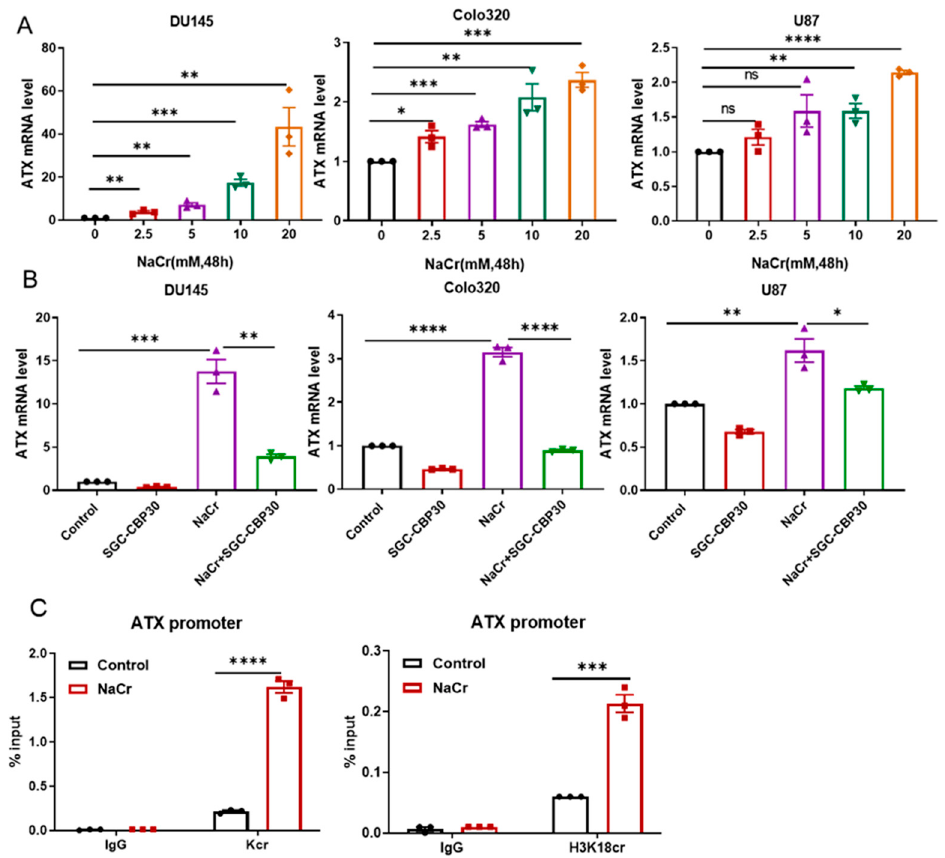
Figure 7. Histone crotonylation promotes ATX expression under normoxic conditions. ( A ) DU145, Colo320, and U87 cells were cultured under normoxic (N) conditions in the absence or presence of NaCr (0, 2.5, 5, 10, or 20 mM) for 48 h. ( B ) DU145, Colo320, and U87 cells were cultured under normoxic (N) conditions in the absence or presence of NaCr (10 mM) and/or the p300/CBP inhibitor SGC-CBP30 (25 µM) as indicated for 48 h. ATX mRNA levels were measured using RT ‒ qPCR ( A , B ). ( C ) DU145 cells were cultured under normoxic conditions in the absence or presence of NaCr (10 mM) for 48 h and then subjected to ChIP assays with anti-Kcr and anti-H3K18cr antibodies. The PCR amplifications of immunoprecipitated DNA fragments in ChIP assays were performed with primers for site 1. The data shown are the mean ± SEM of n = 3 independent experiments. p -values were calculated using two-sided unpaired Student’s t tests ( A – C ). * p < 0.05; ** p < 0.01; *** p < 0.001; **** p < 0.0001.